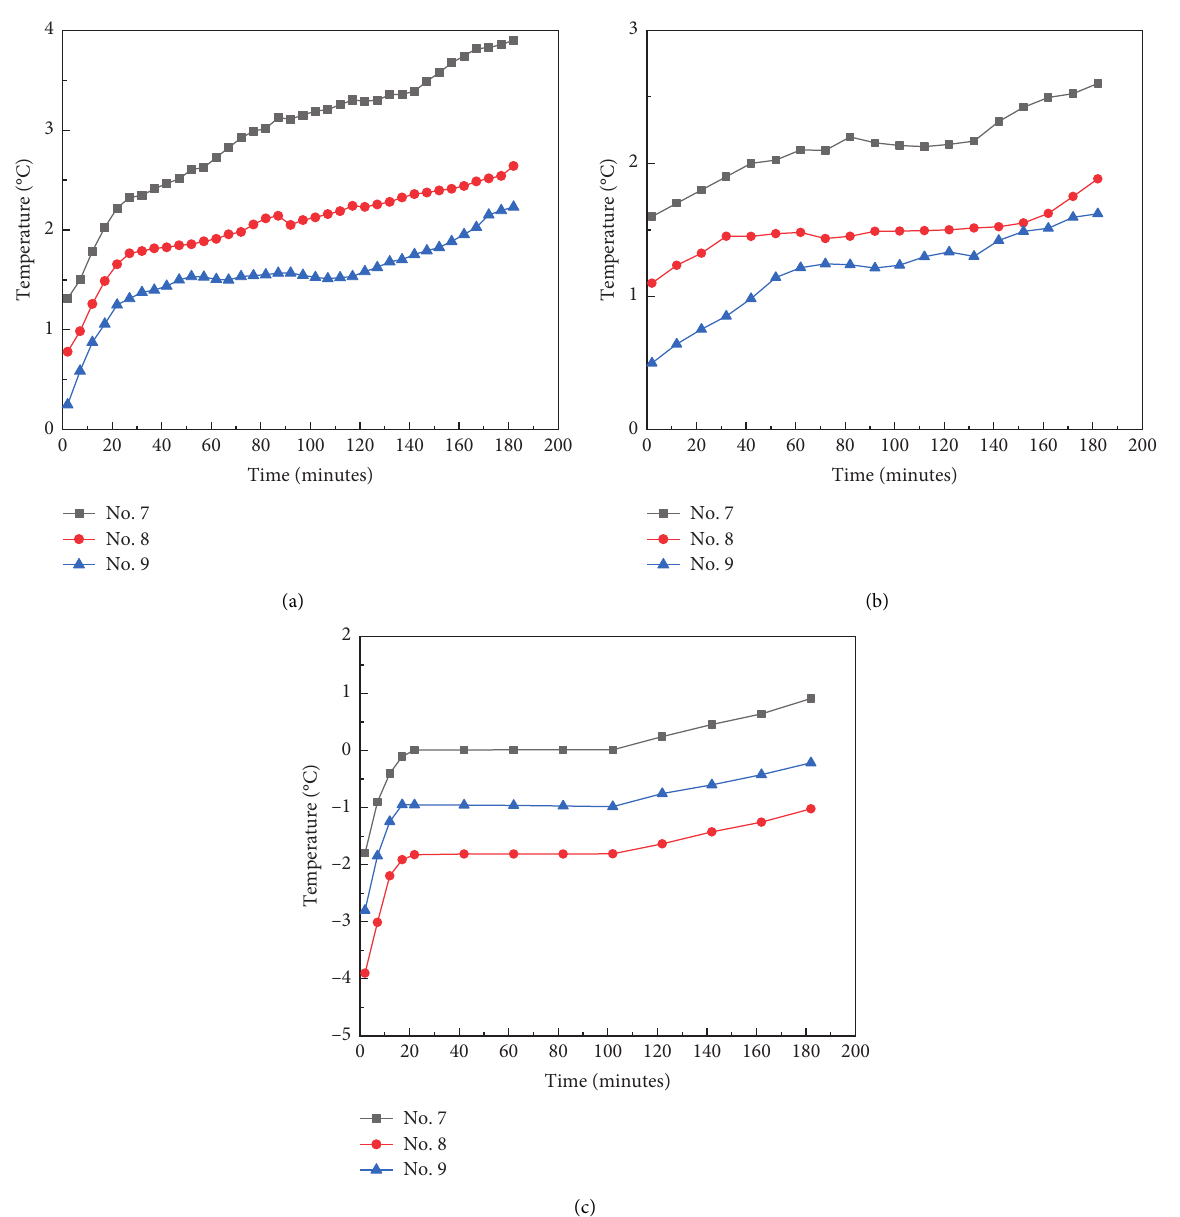
Figure 10: Temperature change curves of measuring points Nos. 7, 8, and 9 under various working conditions of temperature rise Table 5: Temperature change rate of the first layer’s measuring points Nos. 7, 8, and 9 of the temperature rise experiment. Environmental conditions Average temperature when cooling for 3 h ( °